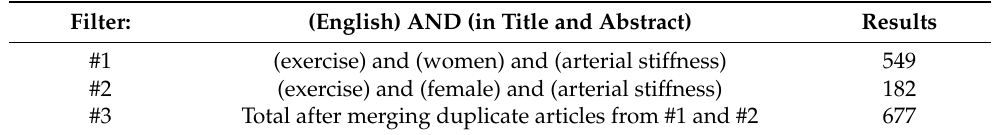
Table 1. Search strategy for Web of Science.